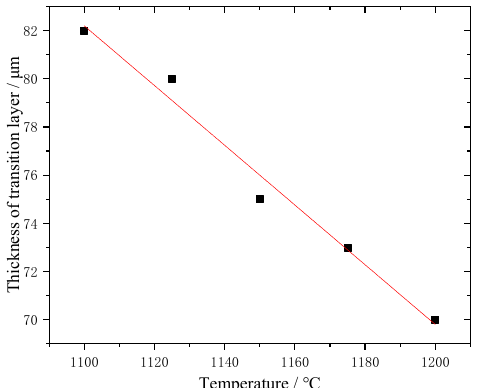
Figure 10. Thickness of the transition layer at different temperatures.